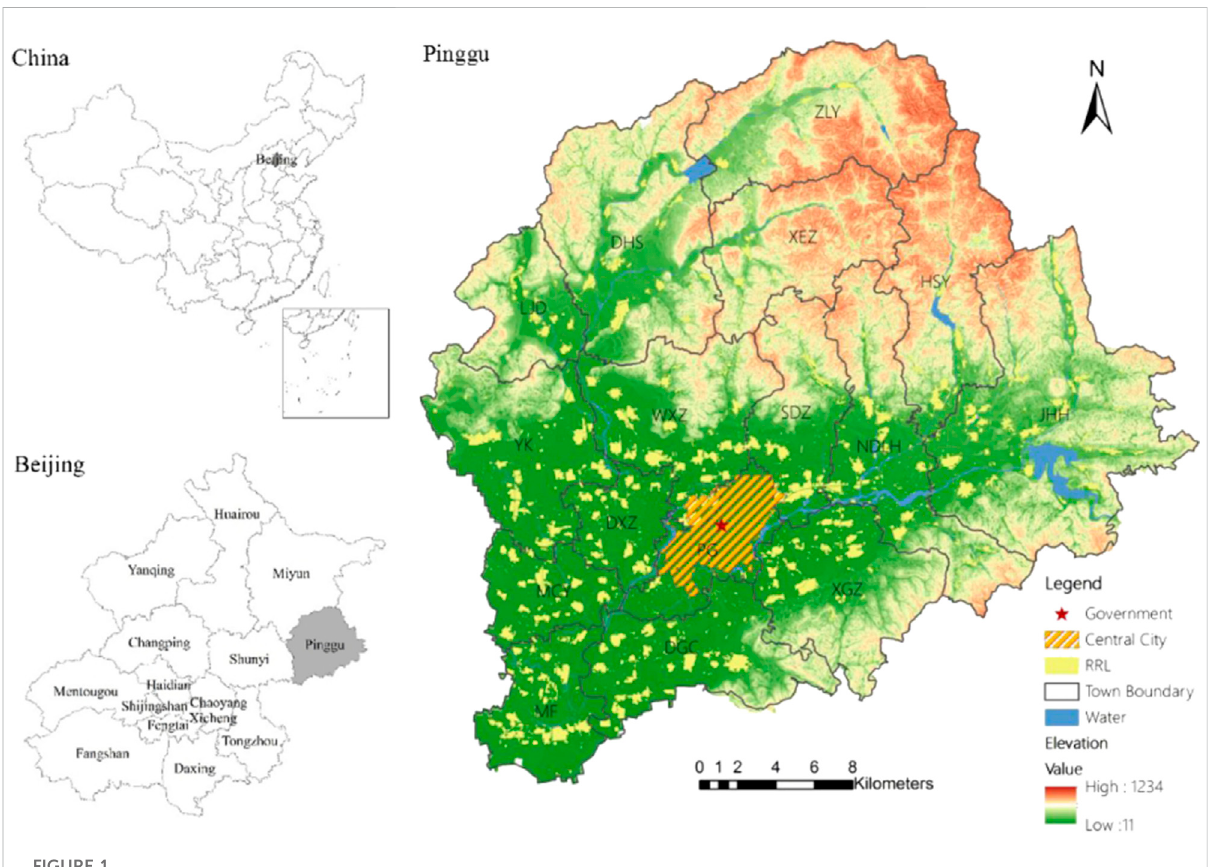
FIGURE 1 The geographical location of